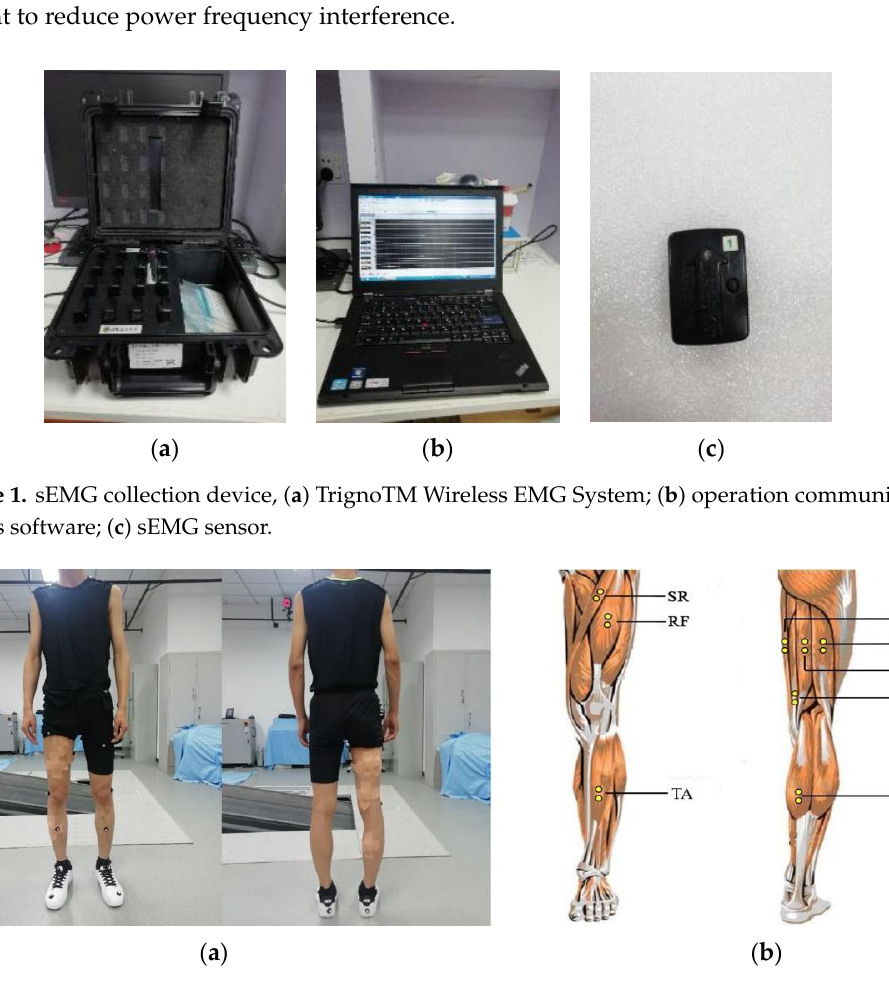
Figure 2. ( a ) Location diagram of sEMG sensors; ( b ) schematic diagram of human lower limb muscles used in this study.